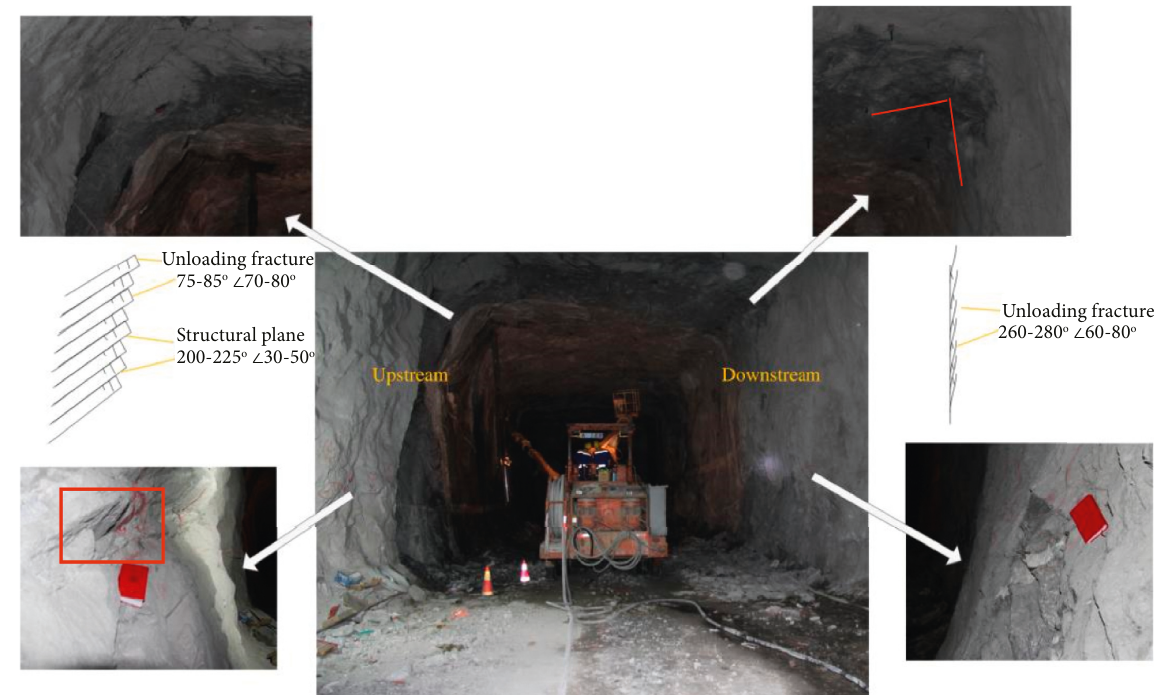
Figure 21: Failure mode diagram of the auxiliary powerhouse.